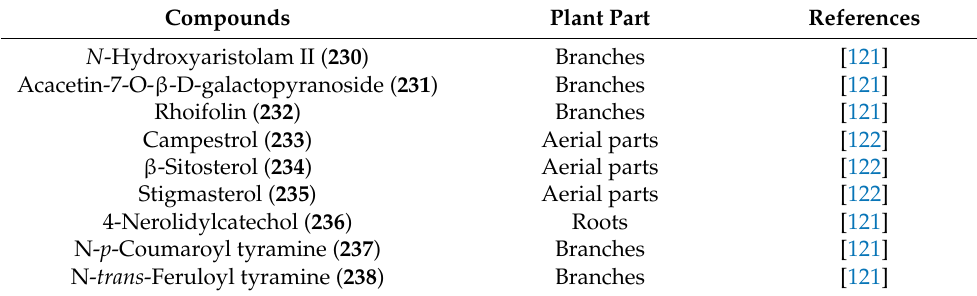
Table 7. Chemical constituents of P. umbellatum .